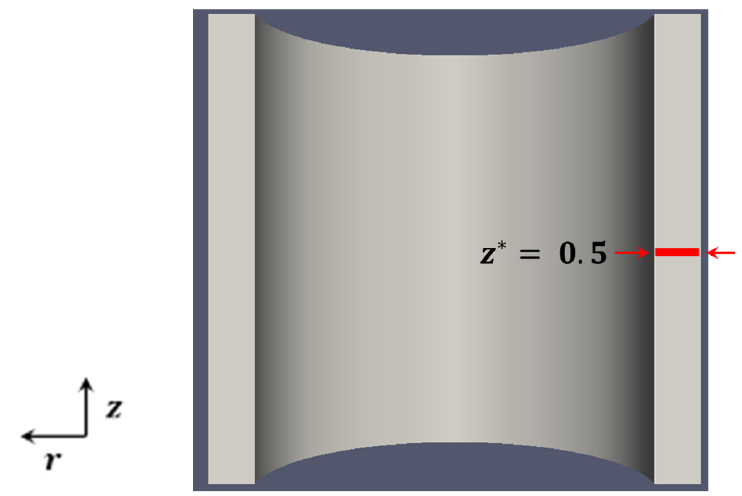
Figure 9. Position of the area of measurement in the studied geometry.